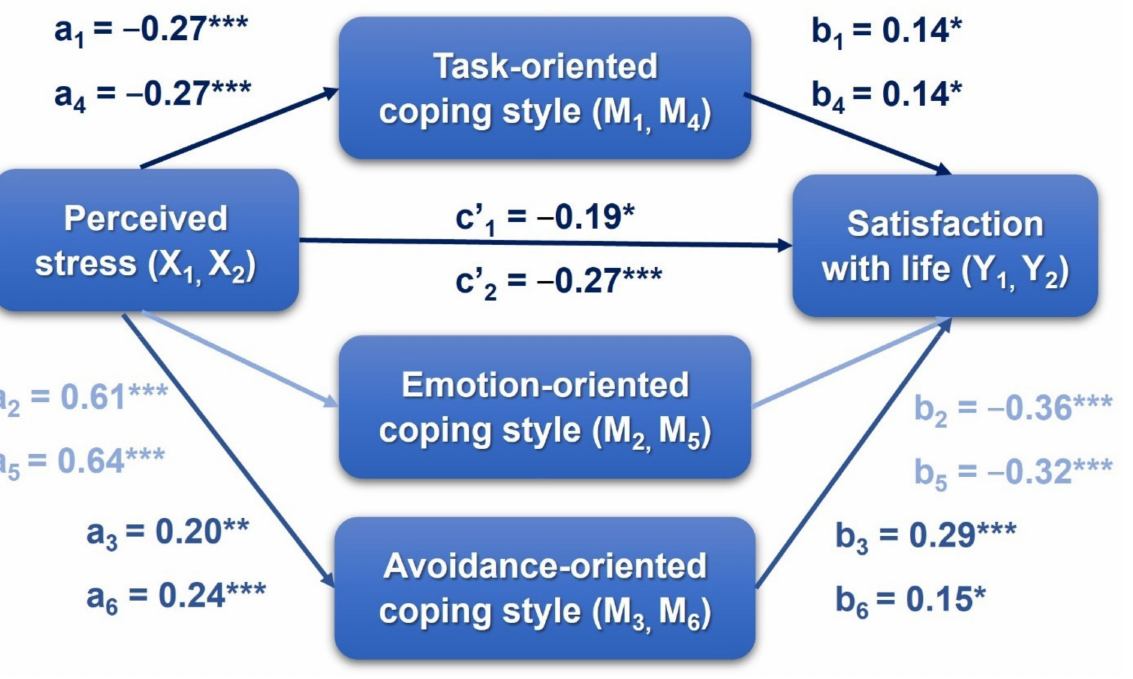
Figure 3. Path model of mediation of the effect of perceived stress on satisfaction with life, via coping styles; cross-sectional design (Model 1 and Model 2). * p < 0.05, ** p < 0.01, *** p <